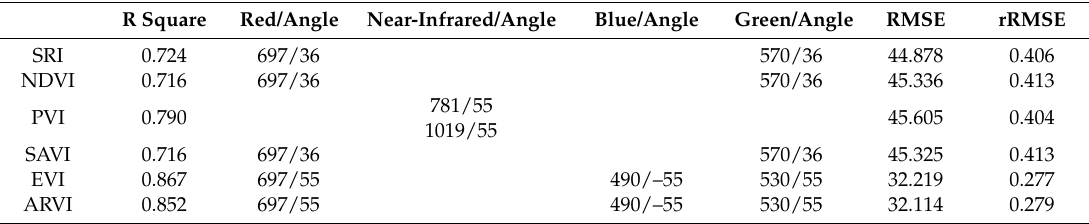
Table 8. Optimal bands and angles using ground measure and a CHRIS